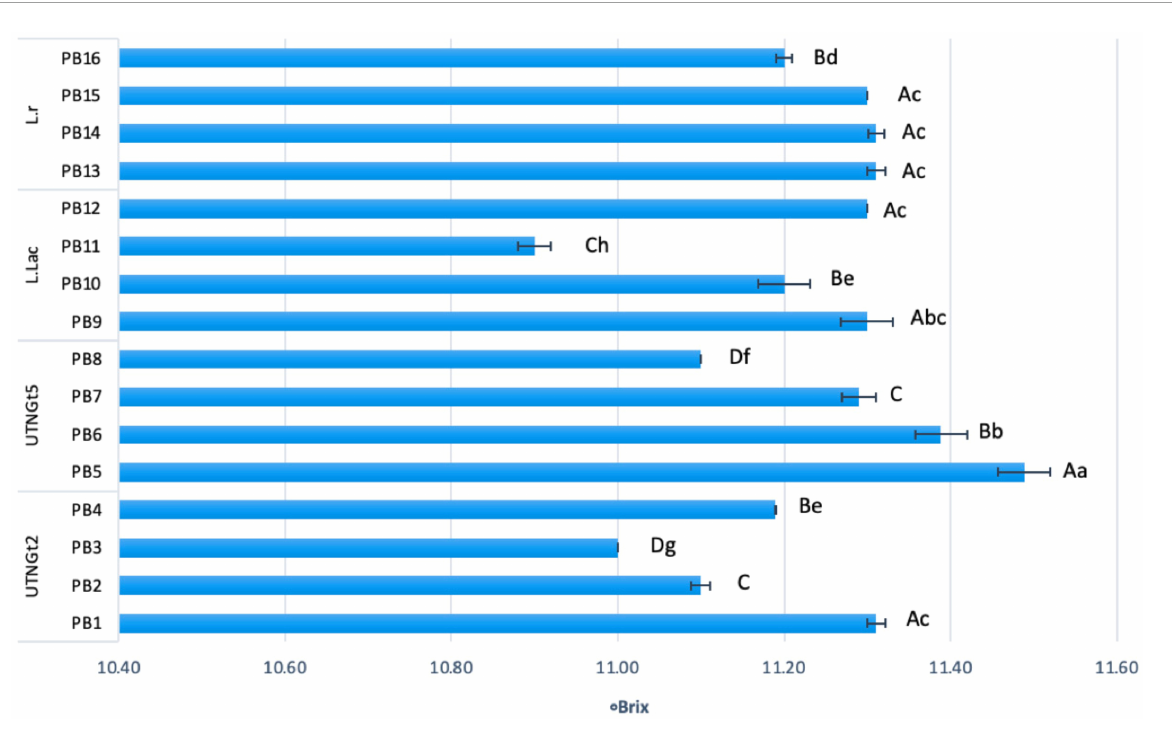
FIGURE4 Total solids ( ◦ Brix) comparison between the PBs at day 21 of storage. Bars are the means ± standard error. Values with different letters are significantly different p < 0.05. Small letters show the difference between the beverages (LSD with Bonferroni correction); Capital letters indicate the differences within strain (Duncan’s test). Legend: PB1–PB4: (CSMF1–CSMF4) + UTNGt2; PB5–PB8: (CSMF1–CSMF4) + UTNGt5; PB9–PB12: (CSMF1–CSMF4) + L.Lac; PB13–PB16: (CSMF1–CSMF4) + L.r. CSMF1: semi-skimmed milk + 1% cocoa + 2% glucose; CSMF2: